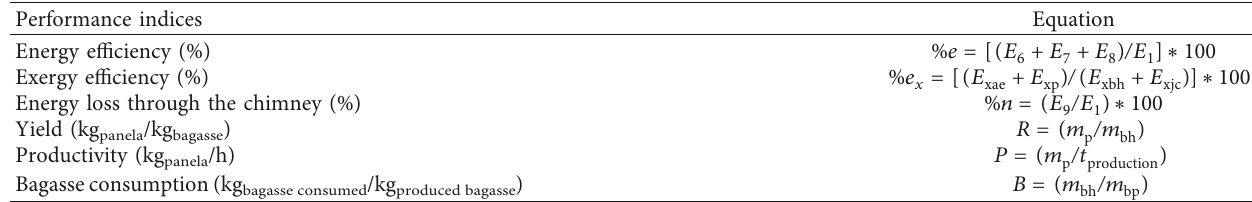
Figure 4: Exergy balance for the traditional furnace, exergy in kJ. Humid bagasse (Ex bh ), sugarcane juice (Ex jc ), evaporated water (Ex ae ), panela (Ex p ), chimney gases (Ex gh ), and exergy destruction (Ex dp ). Ex ap represents the exergy harnessed and consumed during the operation and corresponds to the sum of Ex ae and Ex p Table 1: Performance indices used to assess the traditional furnace.